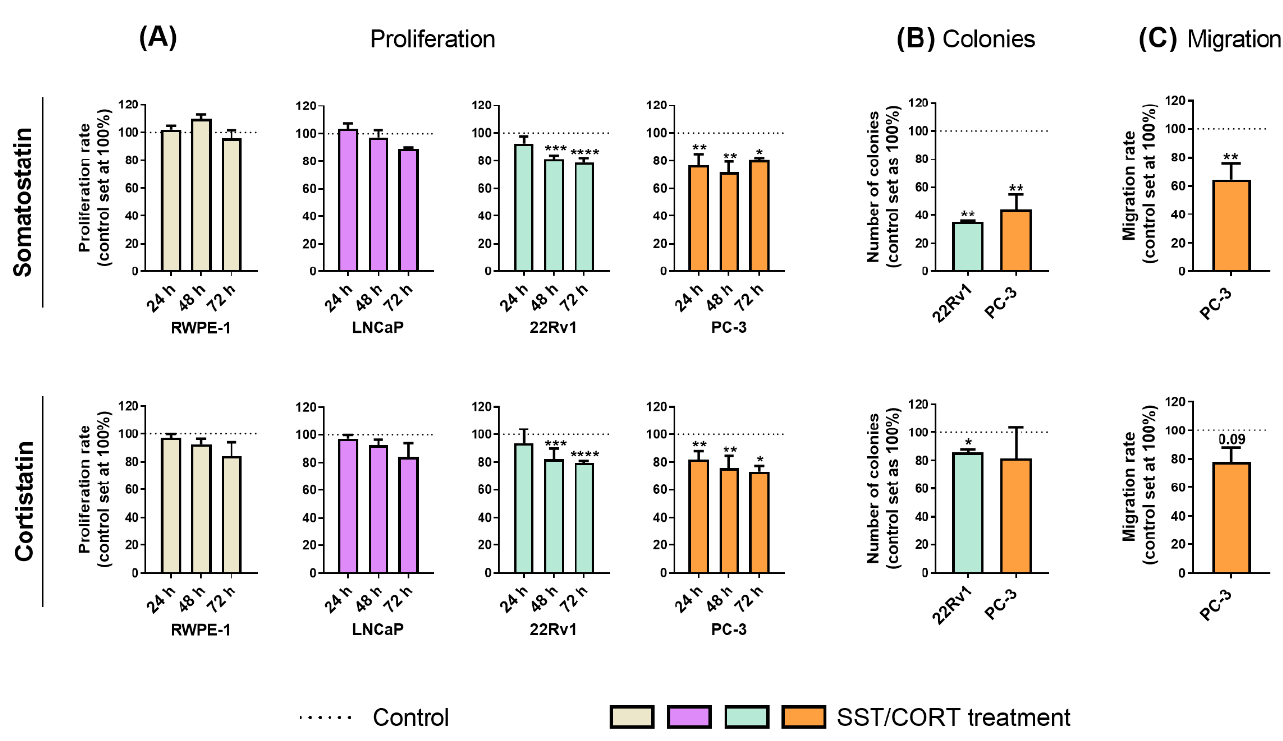
Figure 1. Functional effects after somatostatin (SST) and cortistatin (CORT) treatment in prostate cells. ( A ) Proliferation rate of normal prostate (RWPE-1) and prostate cancer (PCa) cells [androgen- dependent (LNCaP) and androgen-independent (AI; 22Rv1 and PC-3)] in response to SST and CORT treatment (after 24, 48 and 72 h). ( B ) Colonies formation in response to SST and CORT treatment in AI-PCa cells. ( C ) Migration rate of PC-3 cells after 16 h of SST and CORT treatment. Data were represented as percent of vehicle-treated cells (set at 100%). Asterisks (* p < 0.05; ** p < 0.01; *** p < 0.001; **** p < 0.0001) indicate statistically significant differences between groups.